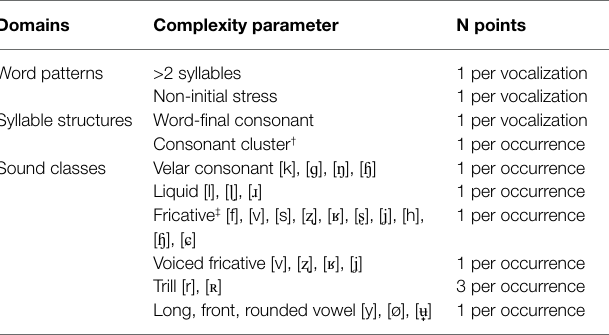
TABLE 2 | The WCM-SE measure as implemented in the present study, based on Marklund et al. (2018). Each transcribed vocalization was given a WCM-SE score, after which a subject mean score was calculated.